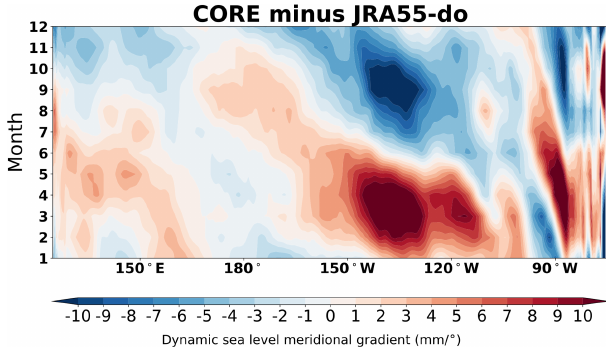
Figure 21. Hovmöller diagram of monthly climatology (1993– 2007) with mean state removed showing the meridional mean (2 to 10 ◦ N) of the DSL gradient (shading in mm/degree) difference by subtracting the JRA55-do-forced simulation from